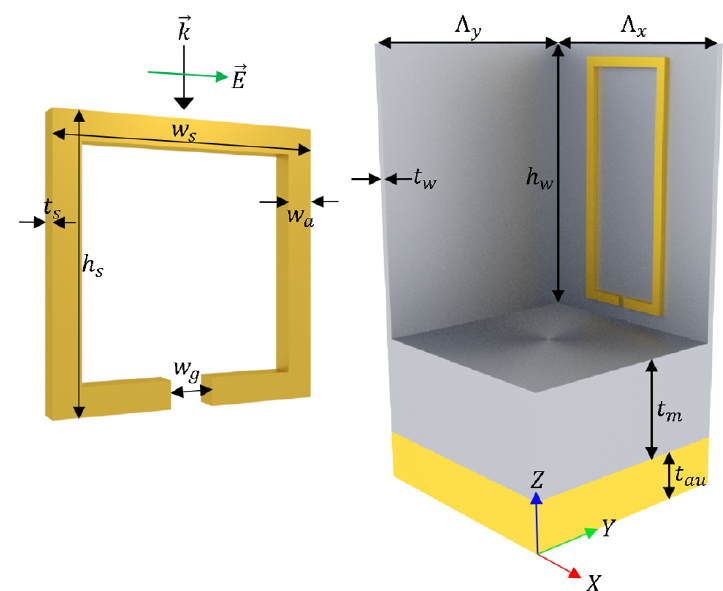
Figure 1. The parameters used to define: ( left ) a split-ring resonator (SRR); and ( right ) unit cell are illustrated.